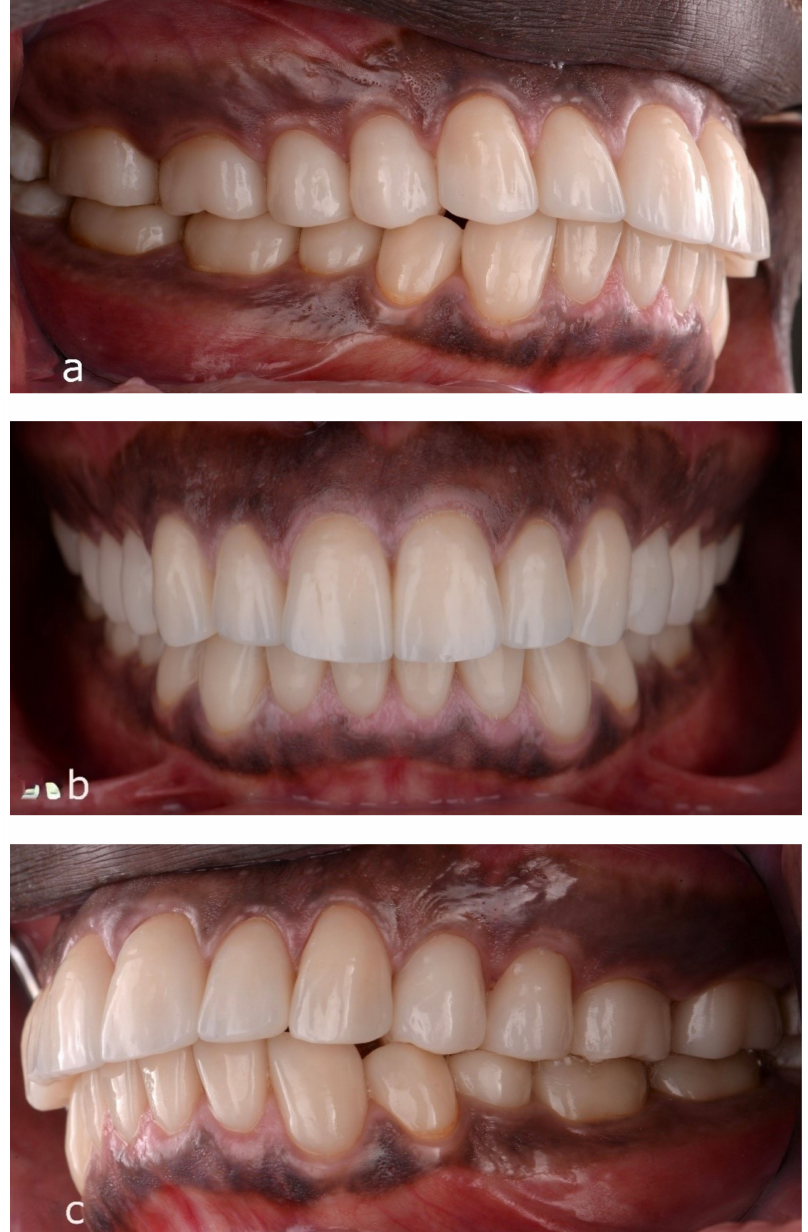
Figure 10. Final restorations bonded using a selective-etch technique: ( a ) right lateral view, ( b ) frontal view, and ( c ) left lateral